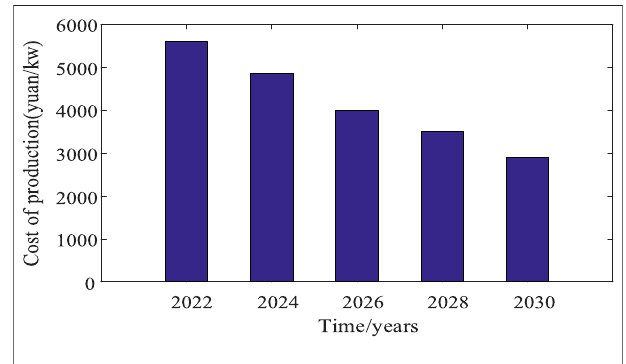
FIGURE 10 | Variation trend of ES cost.